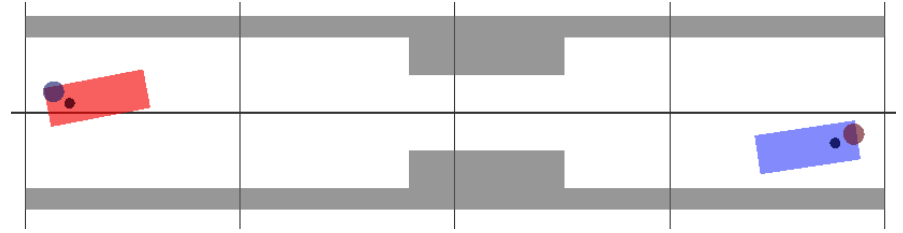
Figure 4. The bottleneck scenario with a centrally placed bottleneck.